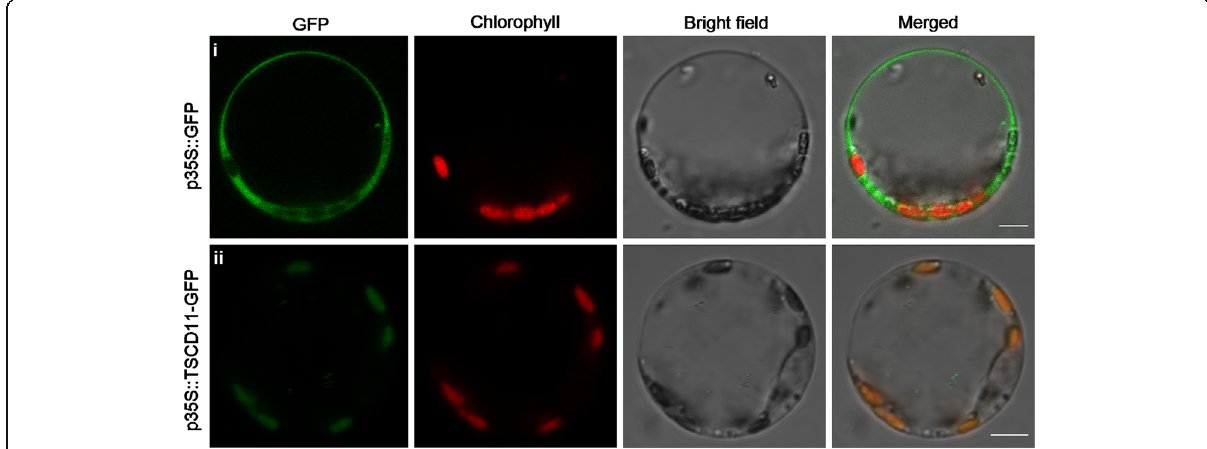
Fig. 6 Subcellular localization of the TSCD11-GFP protein in rice protoplasts. i . Empty GFP as a control. ii. p35S::TSCD11-GFP fusion localized to chloroplast (bar = 5 μ m)